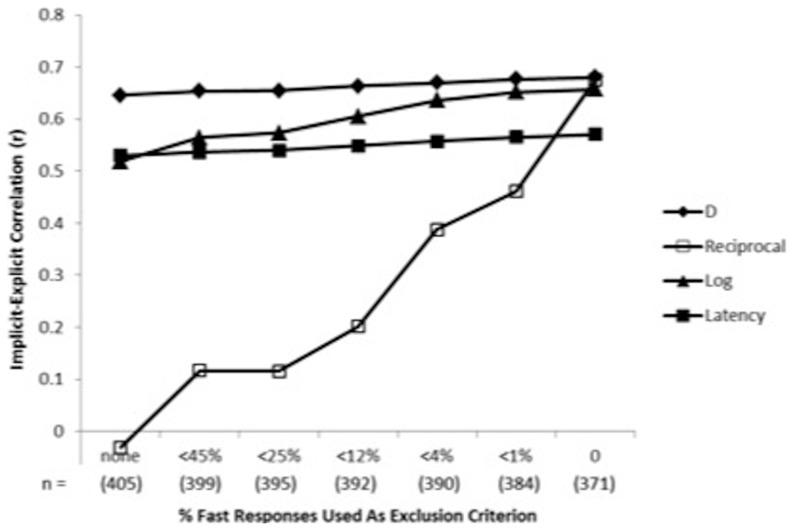
Effects of seven criteria for excluding respondents as a function of their proportion of fast responses (latency <300 ms) on correlations with self-reported preference between Democrats and Republicans for five BIAT data transformations (Study 5).Higher correlations indicate better performance. The furthest left datapoint indicates no exclusion of participants; the furthest right datapoint indicates exclusion of all participants that had even a single fast response. Sample size (n) on the x-axis indicates the number of participants retained with that exclusion criterion.